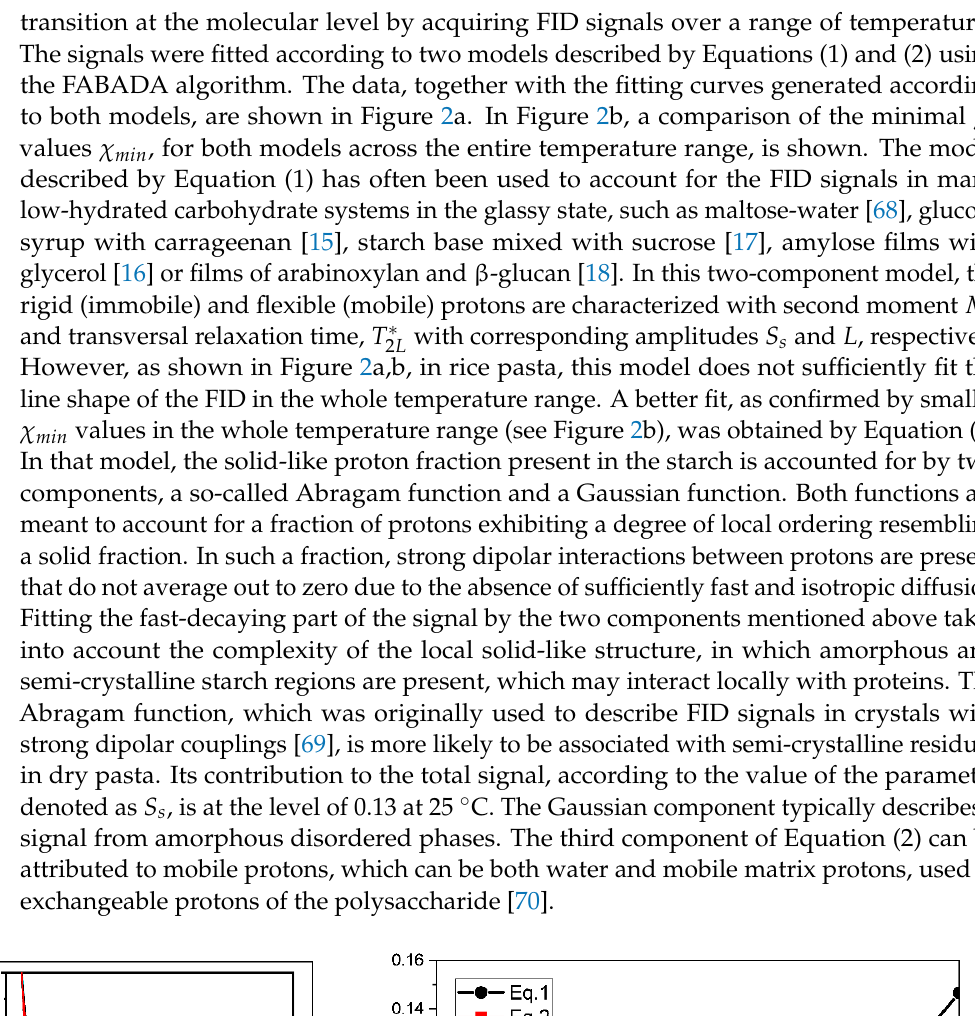
7 of 22 Figure 1. The effect of water content on the (cid:1846) (cid:1859) values measured by DSC. Solid black circles with error bars indicate data points. The solid black line indicates the fit according to the Gordon and